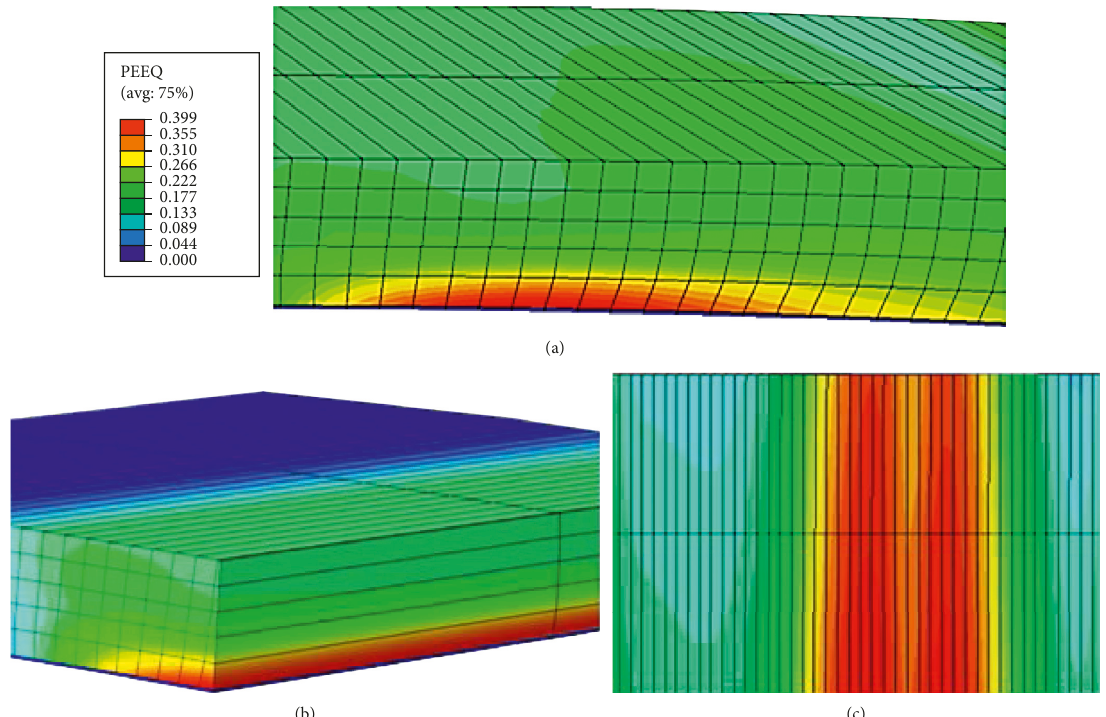
Figure 11: The distribution of equivalent deformations in the thermodeformation hearth (a, b) and in the zone of contact of the tape with the surface of the part (c) with the electrocontact surfacing of the steel tape at K v